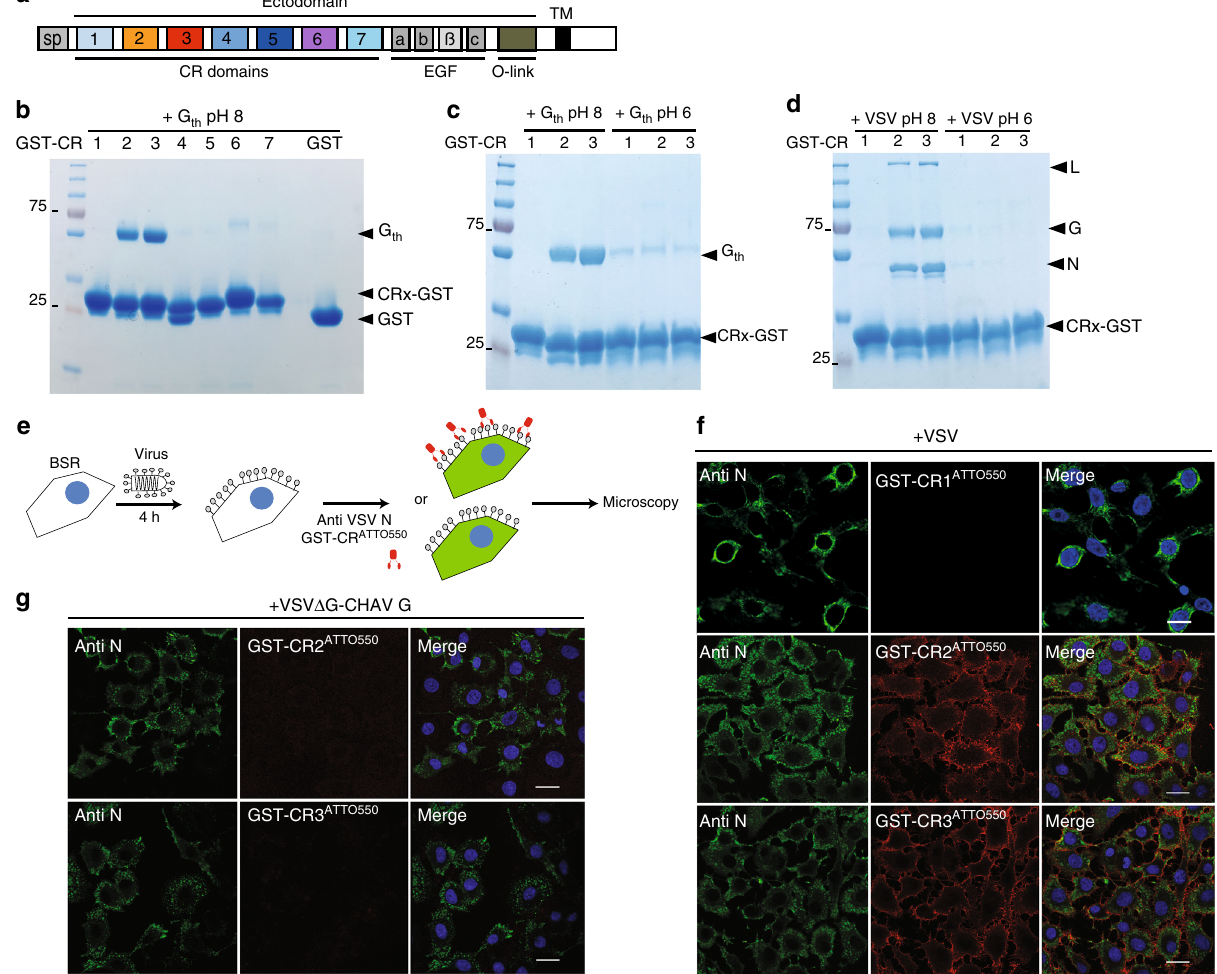
Fig. 1 VSV G interacts speci fi cally with CR2 and CR3 in its pre-fusion conformation. a Scheme of the modular organization of the LDL-R indicating the 7 CR modules (1 – 7), the 3 EGF repeats (a,b and c) , the seven-bladed β -propeller domain ( β ) of the epidermal growth factor precursor like domain (EGF), and the C-terminal domain containing O-linked oligosaccharides (O-link). SP signal peptide, TM transmembrane domain. b SDS – PAGE analysis of interaction experiments between the 7 GST-CR proteins, bound to GSH magnetic beads, and G th at pH 8. c , d Coomassie-stained SDS – PAGE of interaction experiments between GST-CR1, GST-CR2 and GST-CR3, bound to GSH magnetic beads, and G th ( c ) or VSV ( d ) at pH 8 and 6, respectively. Puri fi ed GST- CR bound to GSH magnetic beads were incubated with either G th or VSV in the appropriate pH condition in presence of Ca 2 + for 20 min at 4 °C. Then, after wash, the beads were directly loaded on a gel. As a control in b , GST alone bound to the GSH coated beads was incubated in presence of G th . e Cartoon that illustrates the experiments presented in f and g . After 4 h of infection, BSR cells were labeled with an antibody directed against VSV nucleoprotein (anti-VSV N) to visualize the infection (green fl uorescence) and a GST-CR ATTO550 to probe CR domain recognition by the surface displayed glycoprotein (red fl uorescence). f Labeling of G at the surface of BSR cells infected with VSV using fl uorescent GST-CR1 ATTO550 , GST-CR2 ATTO550 , and GST-CR3 ATTO550 . At 4 h post-infection (p.i.), cells were incubated with the appropriate GST-CR ATTO550 at 4 °C during 30 min prior fi xation and permeabilization and then immuno-labeled using an anti-VSV N antibody to visualize the infection. g Labeling of CHAV G at the surface of BSR cells infected with a recombinant VSV expressing CHAV G (VSV Δ G-CHAVG) using fl uorescent GST-CR2 ATTO550 and GST-CR3 ATTO 550 . Infected cells are labeled using anti-VSV N antibodies. In f and g , DAPI was used to stain the nuclei. Scale bars = 20 µ